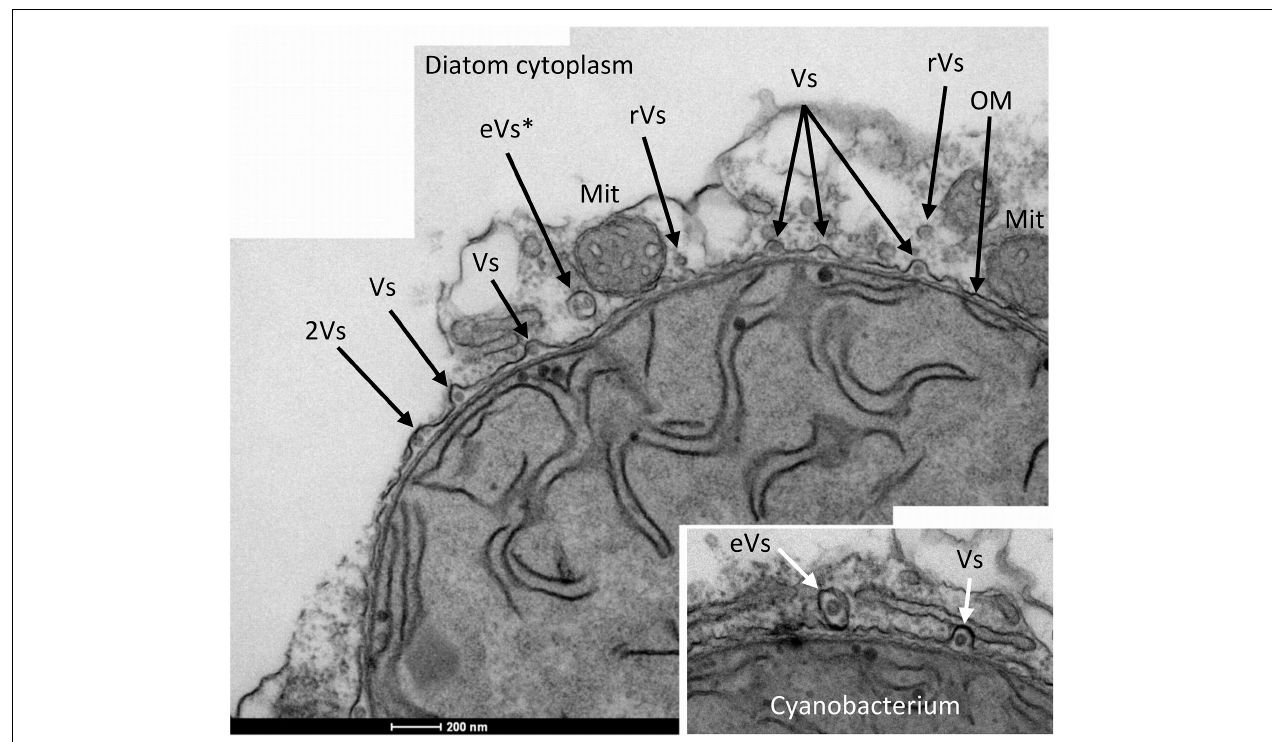
FIGURE 5 | Transmission electron micrographs of sections of a vegetative cell of R. intracellularis endosymbiotic in H. hauckii showing numerous cell envelope-related vesicles. Periplasmic vesicles mainly located in outer membrane evaginations (Vs) and possible recently released vesicles (rVs) can be observed. Two closely located vesicles (2Vs) could be externalized together giving rise to an extruded vesicle such as that shown with two internal vesicles (eVs ∗ ). Two mitochondria nearby the cyanobacterial outer membrane (OM) are also indicated (Mit). In the lower-right micrograph, a possible extruded vesicle containing one internal vesicle is observed